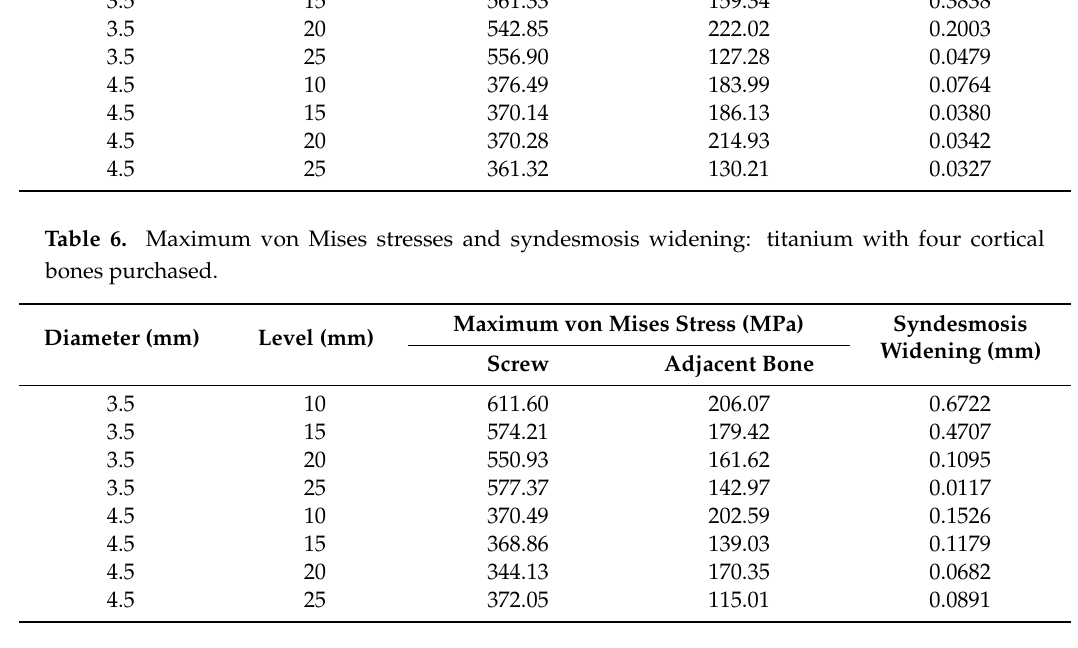
Table 7. Maximum von Mises stresses and syndesmosis widening: stainless steel screw with three cortical bones purchased.